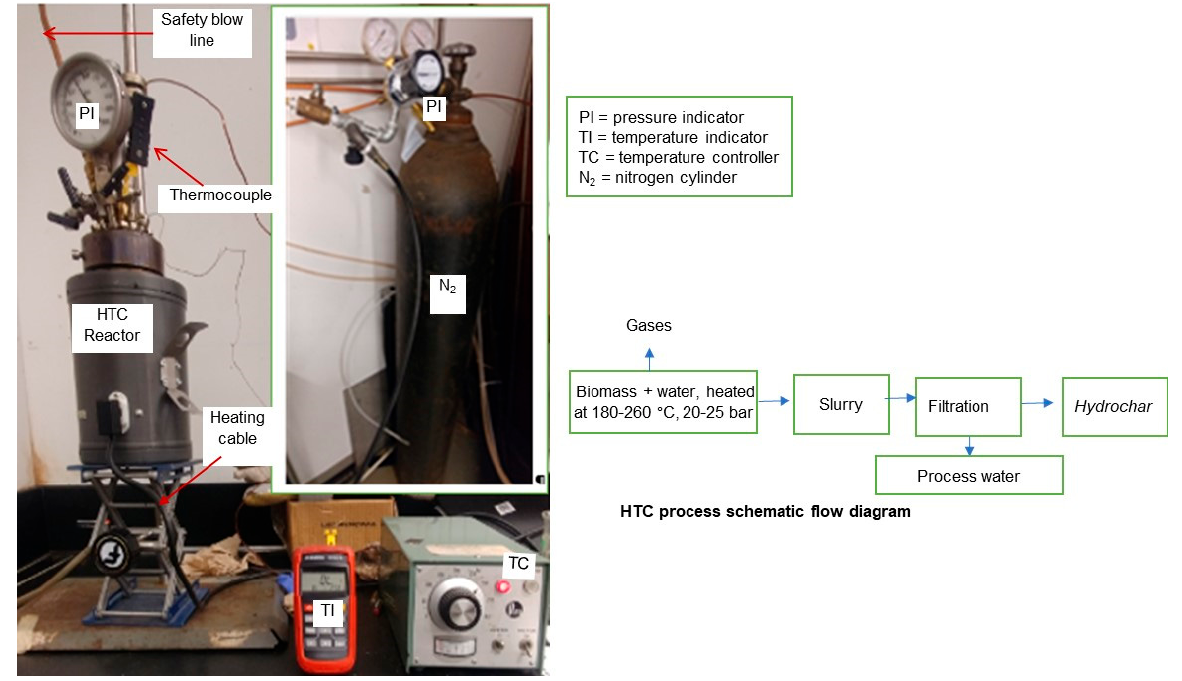
Figure 2. HTC components set-up along with schematic summary of the process.